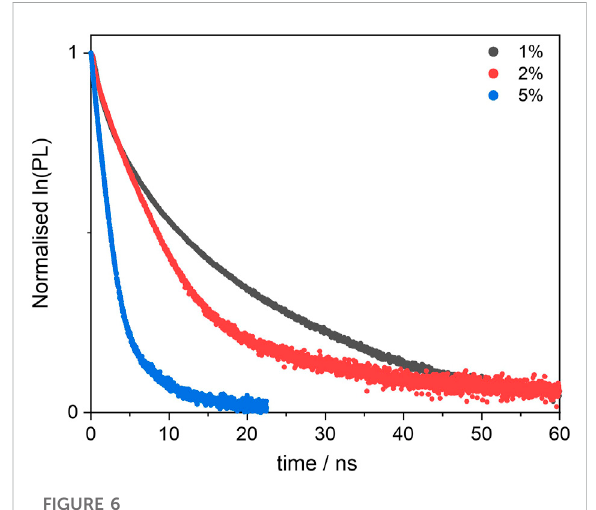
FIGURE 6 Excited state decay pro fi les of the BOPHY1-PMO samples, recorded at λ em = 540 nm, using a 472 nm laser